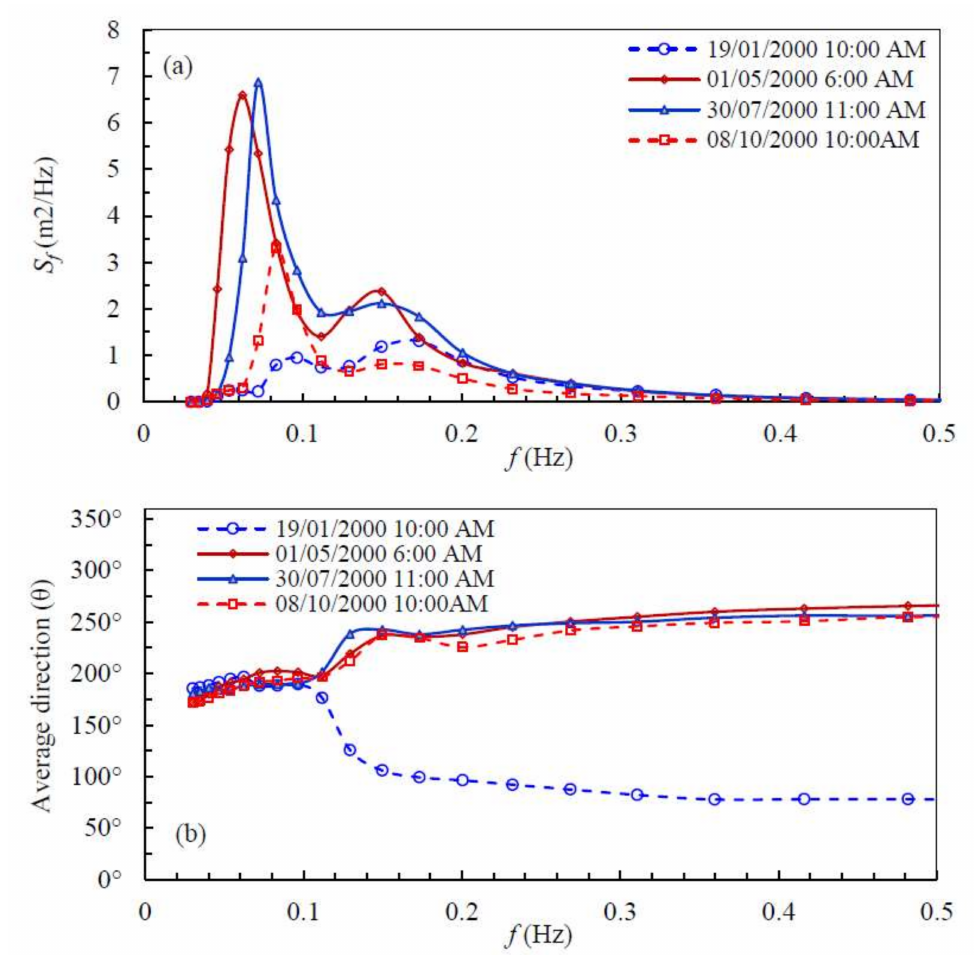
Figure 5. Modelled ( a ) wave spectral densities S f (m 2 / Hz) against frequency f (Hz); and ( b ) predominant spectral direction in 2000 at a location in the south-west (5.931 N, 80.232 E) of Sri Lanka. This is the closed model grid location to wave buoy at Galle (5.93 N, 80.23